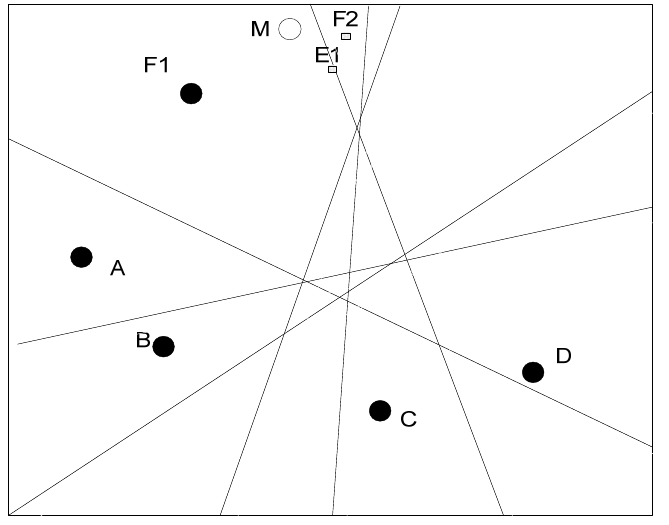
Figure 3. Localization for marginal